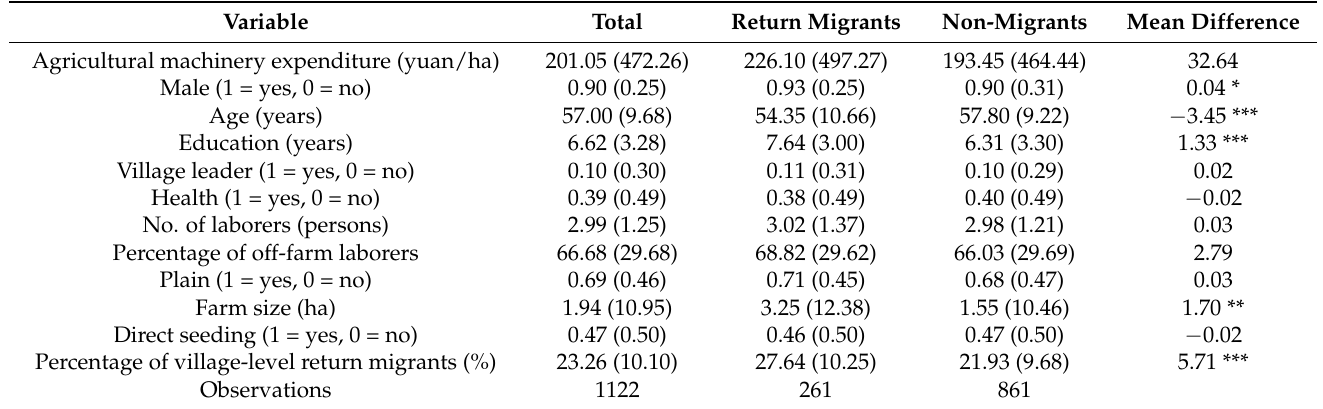
Table 1. Descriptive summary of the main